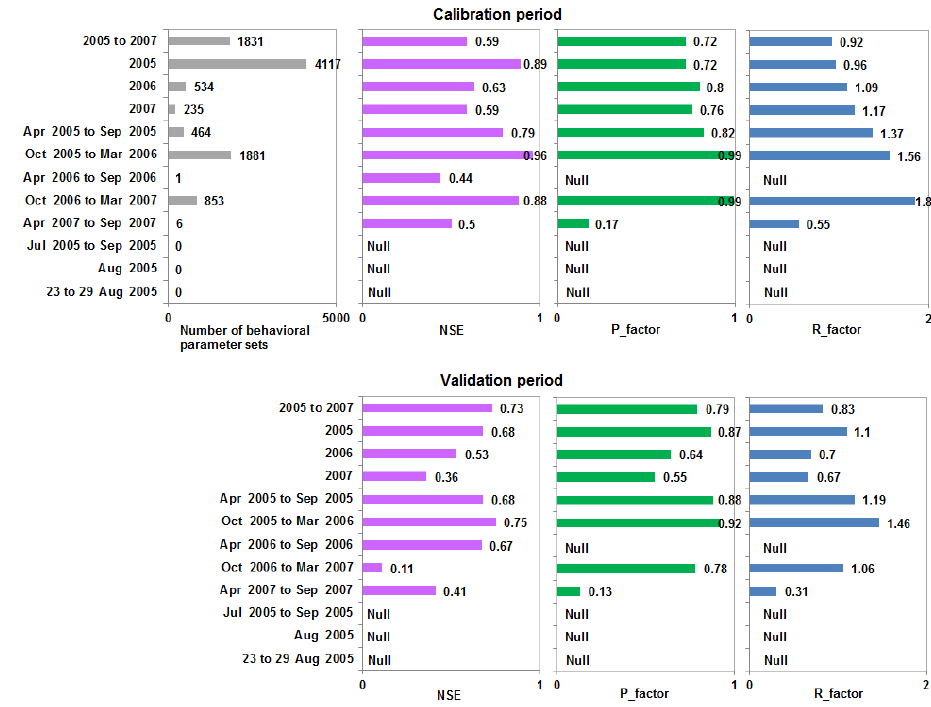
Figure 11. Model performance for the calibrations using short-period data in the Yalongjiang